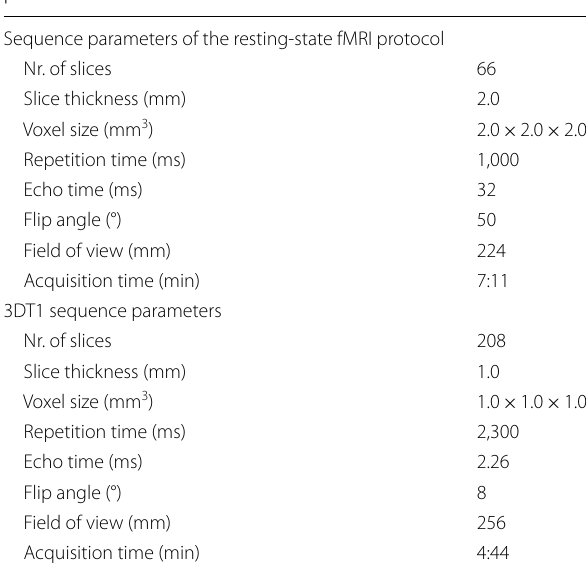
Table 1 Magnetic resonance imaging (MRI) sequence